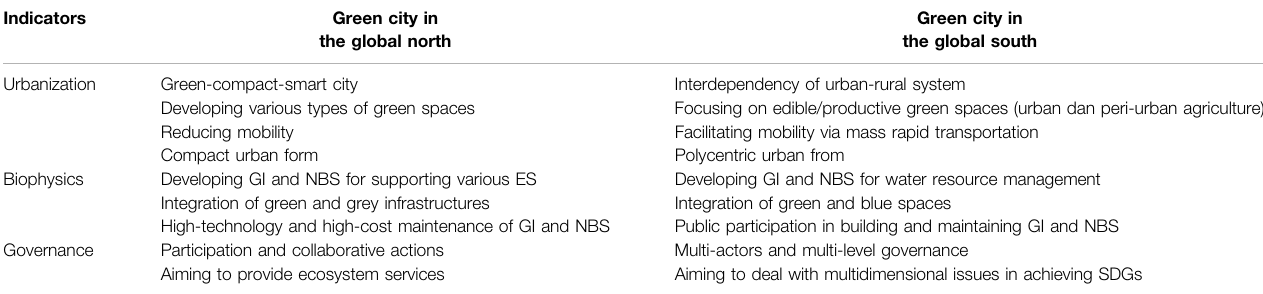
TABLE 4 | Different trajectories of developing potentialities of green cities in the global north and south. Indicators Green city in the global north